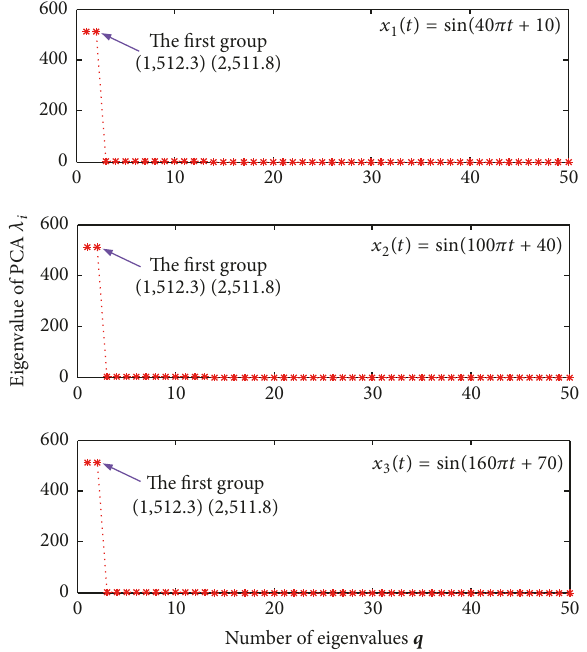
Figure 1: Eigenvalues distribution of covariance matrix C with one frequency component.